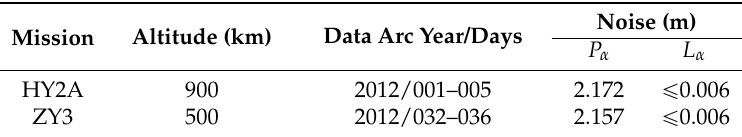
Table 2. Information on missions and